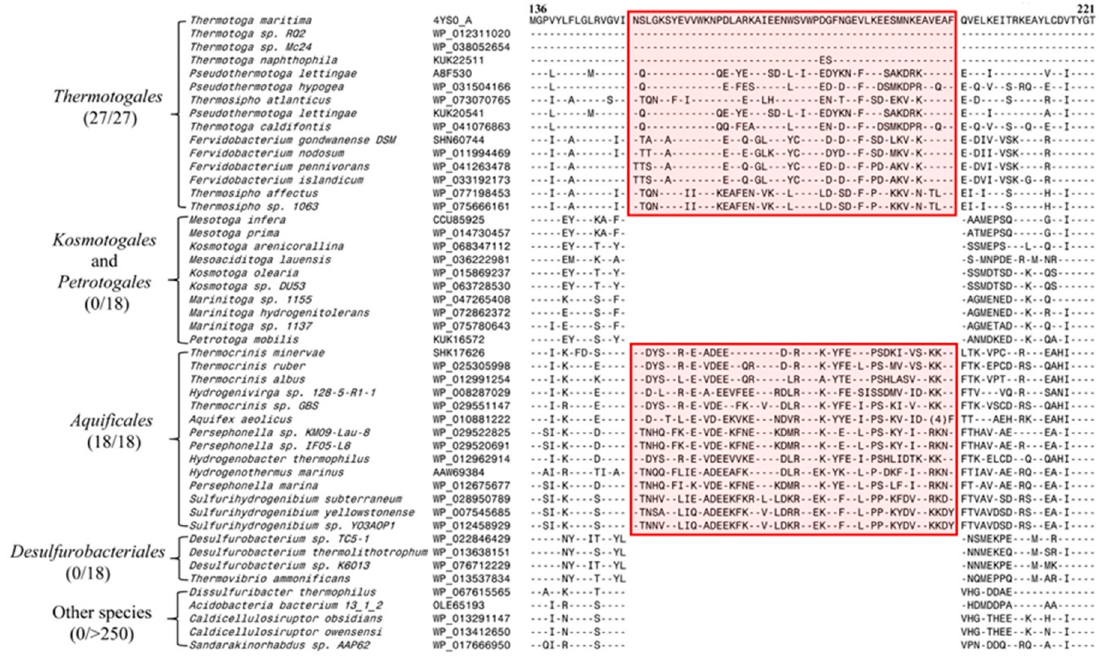
Figure 1. Excerpts from the sequence alignment of SecA protein showing a 50 aa conserved insert that is a distinctive characteristic of species from the orders Thermotogales and Aquificales but absent in the homologs from all other bacteria. The numbers in the parenthesis below the orders’ names indicate the number of species from these orders for which SecA homologs were identified and how many of them contained the indicated insert. The dashes (-) in the sequence alignment denote sequence identity with the amino acid shown on the top line. The accession numbers of the protein sequences are provided in the second column and numbers on top of the sequence alignment indicate the position of this sequence in T. maritima .